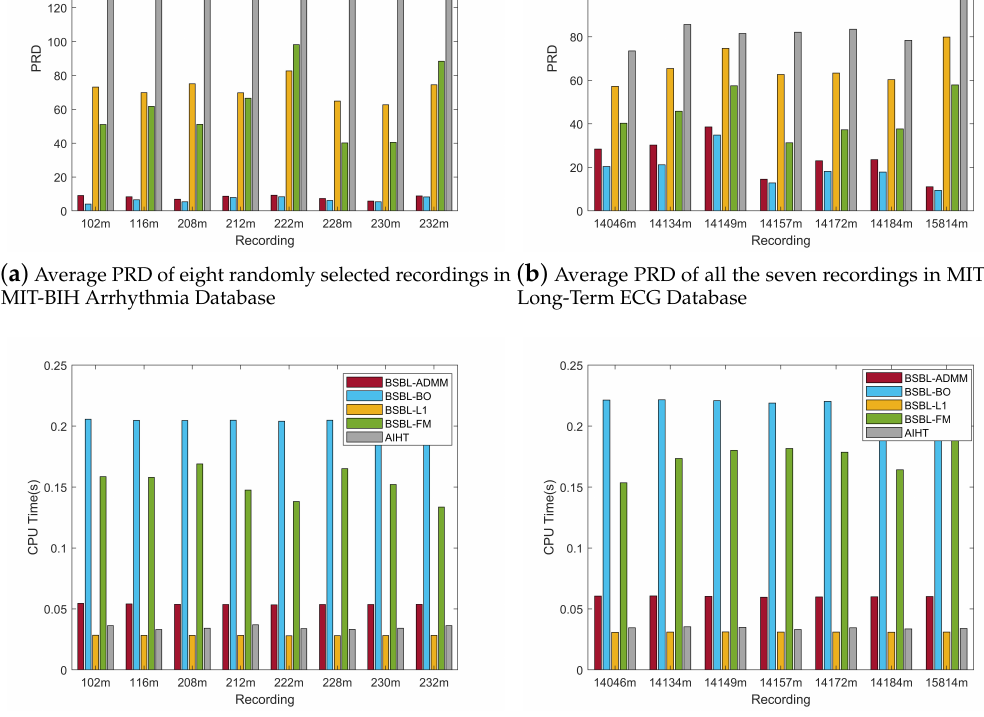
Figure 6. Recovery results of eight randomly selected recordings in MIT-BIH Arrhythmia Database and all seven of the recordings in MIT-BIH Long-Term ECG Database. ( a , b ) show that the BSBL-ADMM has relatively stable recovery accuracy for different recordings; ( c , d ) show that the the BSBL-ADMM has relatively stable CPU times for different recordings. All these results on MIT-BIH Databases demonstrate the robustness of the proposed BSBL-ADMM